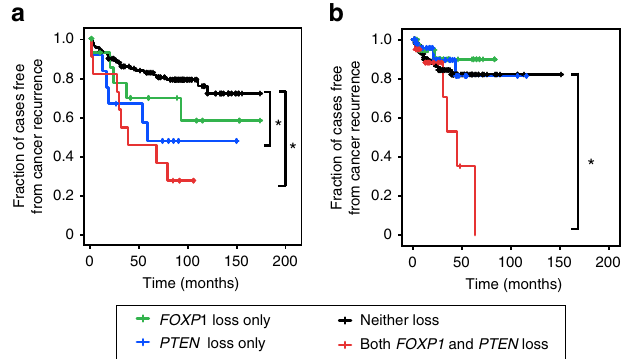
Fig. 4 Cooperative loss of FOXP1 , a 3p13-14 deletion gene, and PTEN is associated with human prostate cancer recurrence. a Kaplan – Meier curve of biochemical recurrence in the MSKCC primary prostate cancer cohort by combined FOXP1 and PTEN loss, FOXP1 only loss, PTEN only loss, or loss of neither. Log-rank * P < 0.05. b Kaplan – Meier curve of biochemical recurrence in the TCGA prostate cancer cohort as in a . Log-rank * P <